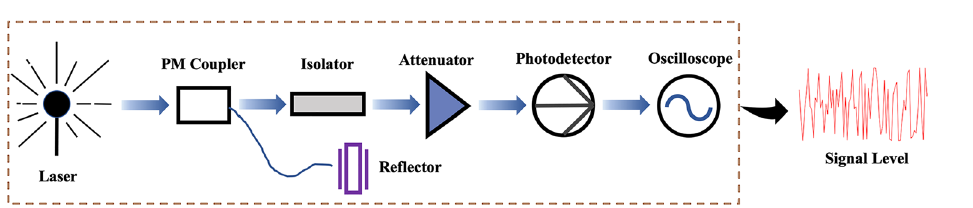
Figure 3. The generation process of laser chaos where a semiconductor laser emits laser light through the beam splitter to a laser reflector, and the delayed light injects into a diode laser emitter